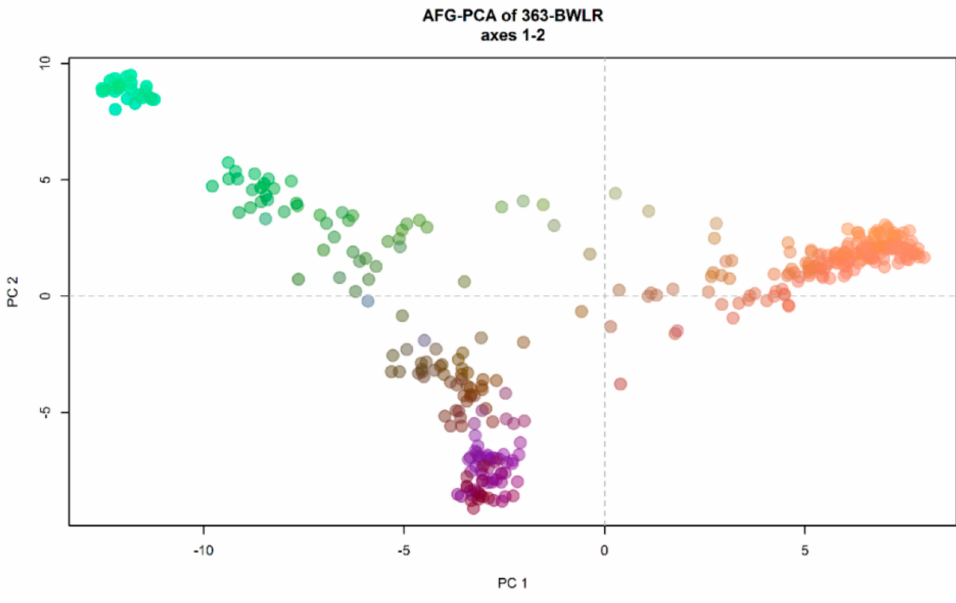
Figure 5. Principal component analysis (PCA) of 363 Afghan bread wheat landraces. colours are coded as the first three principal components (PCs) of the PCA recorded, respectively, on the red, green, and blue